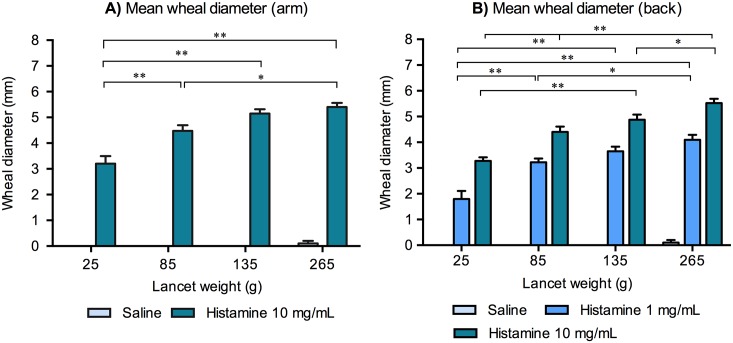
A) The mean wheal diameters on the forearms for each lancet weight; 25 g, 85 g, 135 g and 265 g. A higher lancet weight significantly increased the sizes of the wheal reactions. B) The mean wheal diameters on the back for each lancet weight; 25 g, 85 g, 135 g and 265 g. A higher lancet weight significantly increased the sizes of the wheal reactions. A significant difference was also observed when comparing the two histamine concentrations: 1 mg/mL and 10 mg/mL. For each condition; n = 20. * = p < 0.05, ** = p < 0.01. Mean ± SEM.